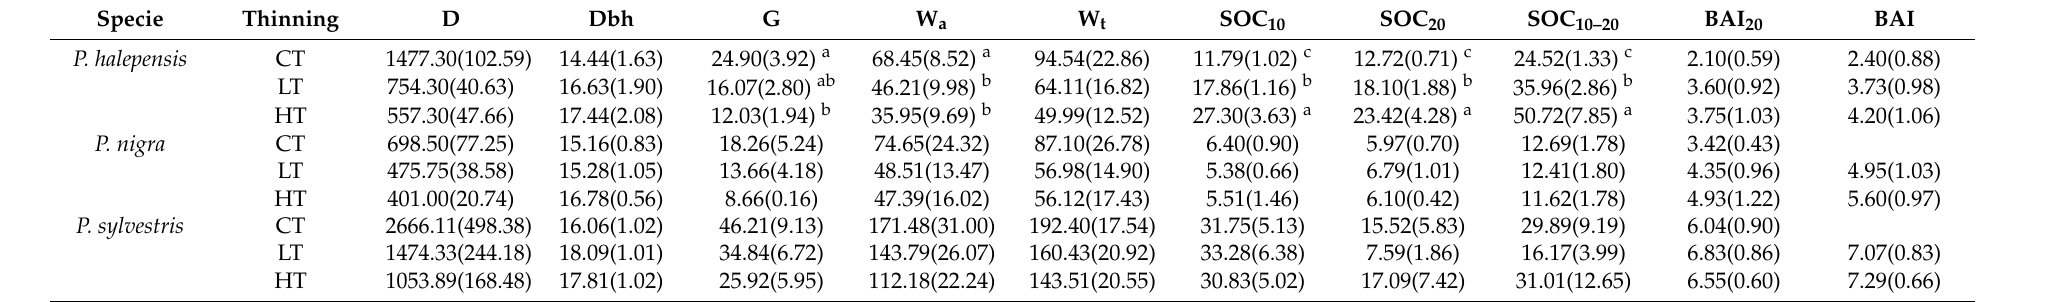
Table 1. Silvicultural characteristics, biomass, soil organic carbon stocks and Basal Area Index (BAI, cm 2 ) of Pinus halepensis ( n = 3 plots), P. nigra ( n = 3 plots) and P. sylvestris ( n = 4 plots) plantations according to the thinning intensity (CT, Control or unthinned plots; LT, light thinning, 30–40% basal area removed; HT, heavy thinning, 50–60% of basal area removed) at several locations along a latitudinal gradient in Spain. Post thinning variables and abbreviations: stem density (D, trees ha − 1 ); diameter at breast height (dbh, cm); basal area (G, m 2 ha − 1 ), post-thinning dbh increment ( ∆ dbh, cm), aboveground (Wa) and total biomass C